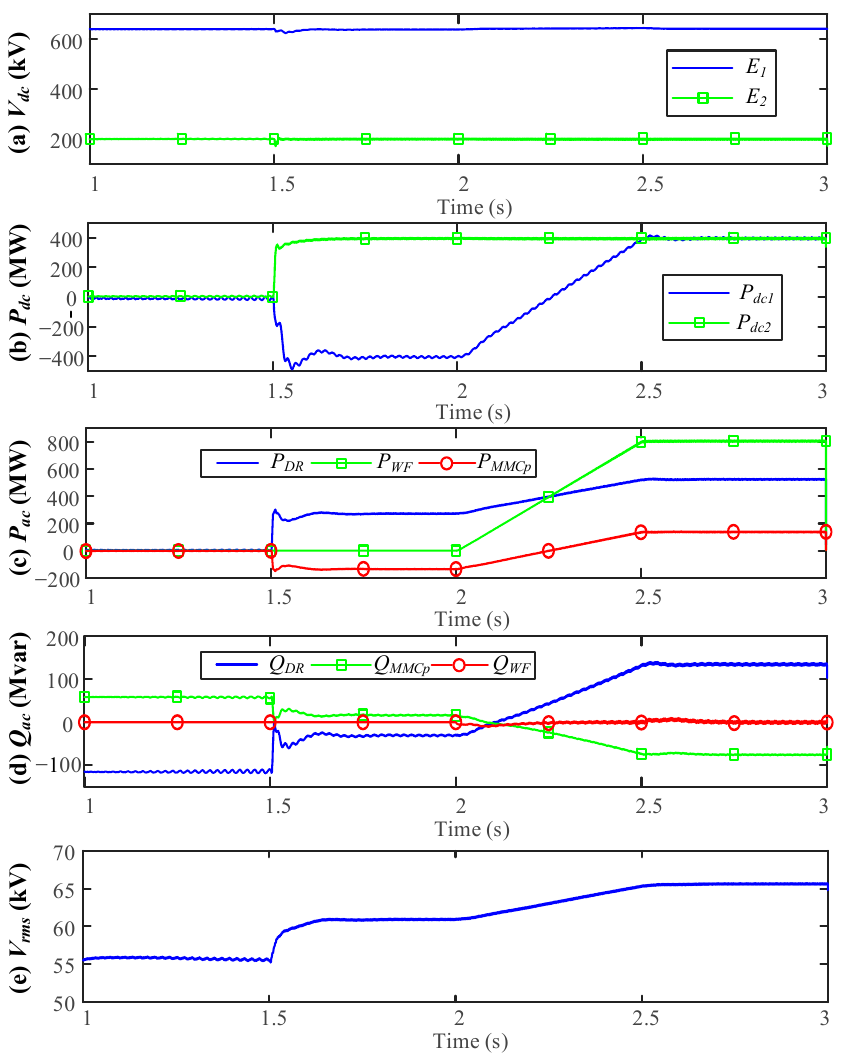
Figure 5. System operation in V dc -V ac control mode: ( a ) DC voltage; ( b ) DC power; ( c ) Active power; ( d ) Reactive power; ( e ) RMS AC voltage.